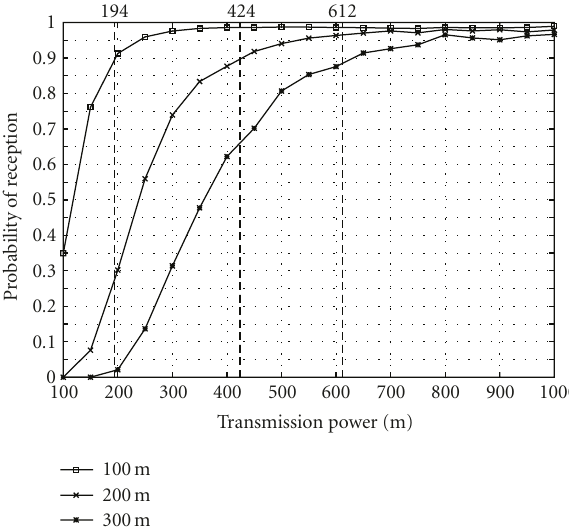
Figure 9: Scenario B (cf. Table 4). Probability of packet reception w.r.t. chosen power value: analytical computation (numbers) and simulative results (curves).